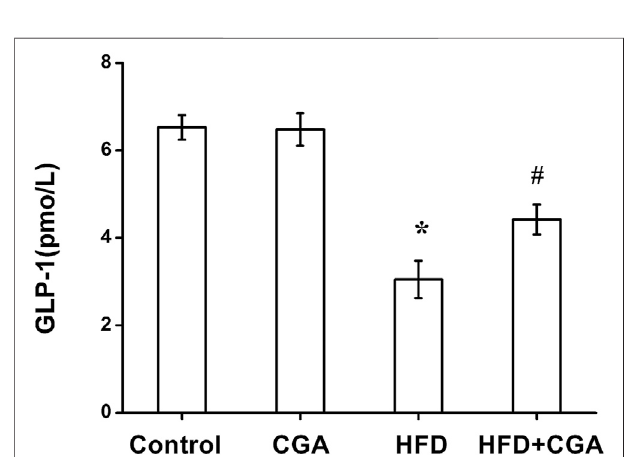
FIGURE 5 | Effect of CGA on the level of LPS in portal vein. Data are presented as mean ± SD. * p < 0.05 as compared with the control group; # p < 0.05 as compared with the HFD group.